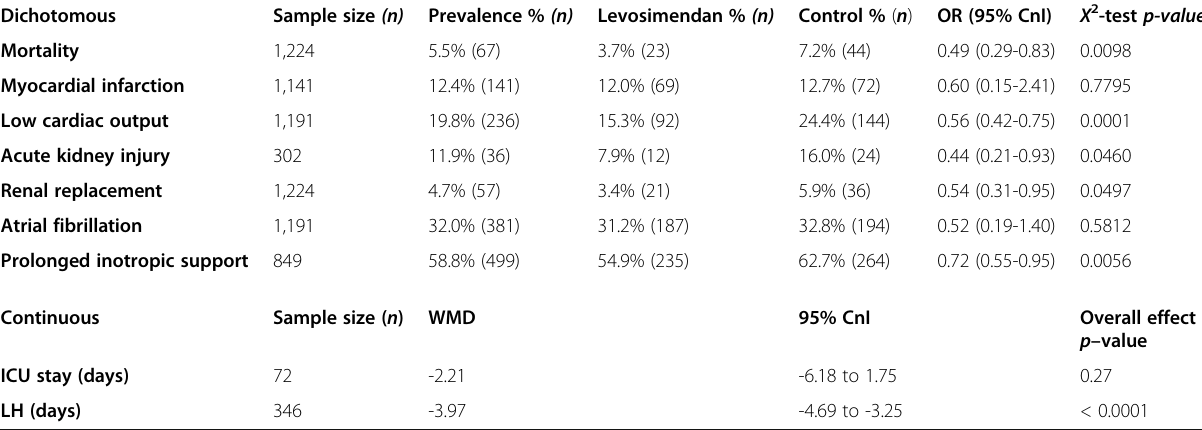
Table 1 Clinical outcomes among RCTs comparing prophylactic levosimendan therapy prior to cardiac surgery in high-risk patients with an ejection fraction of < 35%. In hospital/30 days follow-up. Data from Weber et al. [6]. CI , confidence interval; LH , length of hospital stay; OR , odds ratio, with values < 1 favouring levosimendan; WMD , weighted mean difference, with negative values favouring levosimendan